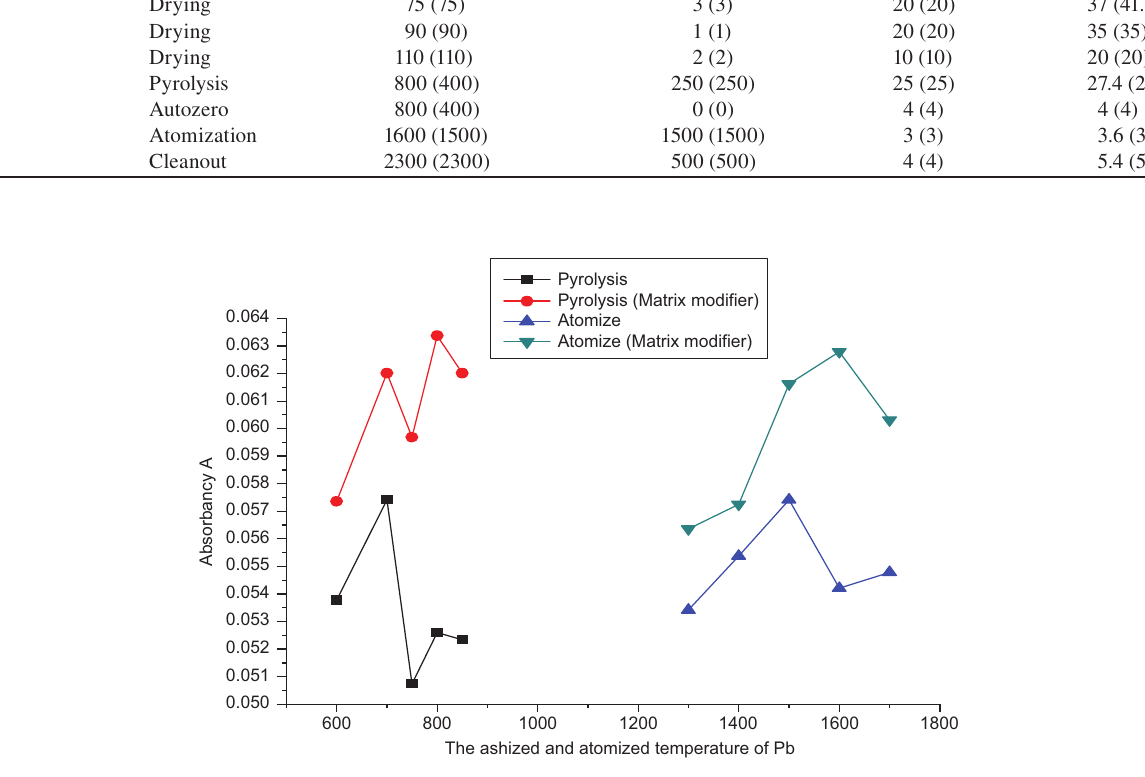
Figure 1 Ashing temperature and atomization temperature of